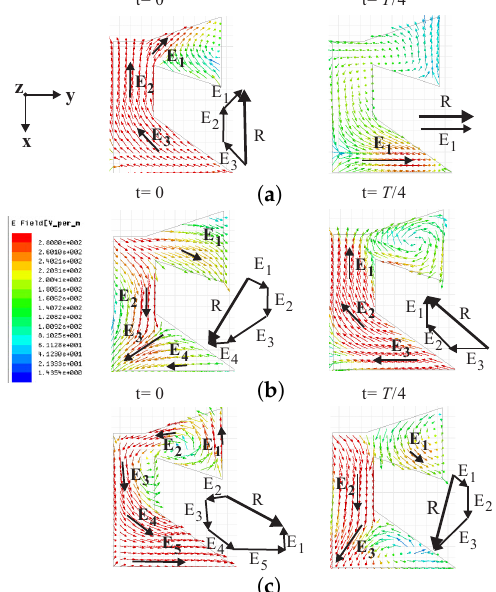
Figure 2. Simulated electric field distributions in a dielectric resonator (DR) with time period T at frequencies of ( a ) 3.5 GHz; ( b ) 4.25 GHz; and ( c ) 5